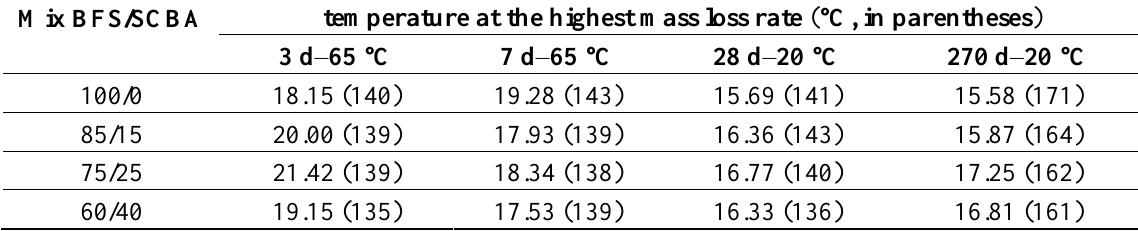
Table 2. Total mass losses in the 35–600 °C range for BFS + SCBA pastes and temperature at the highest mass loss